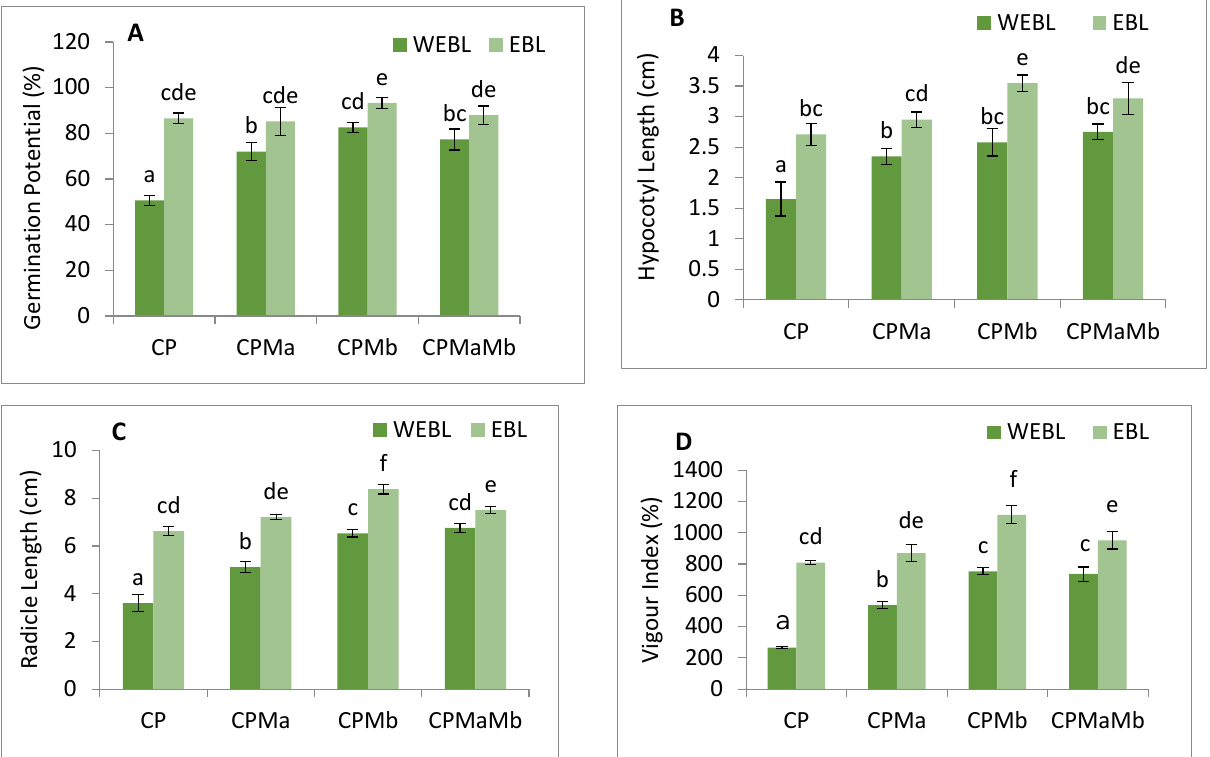
(Figure 1A), hypocotyl growth (Figure 1B) and radicle growth (Figure 1C). The vigour index was used to track the overall growth of the seedlings (Figure 1D). Decreased germination potential, seedling growth and vigour index were observed when CP-treated seedlings were compared in contrast to without CP. However, seed pre-soaking with EBL along with supplementation with Ma and Mb alone and in combinations, i.e., EBLMaMb significantly recovered the seedlings’ growth. Treatment of EBL (100 mM) enhanced the germination potential (41.57%), hypocotyl length and radicle length (39.1 and 45.6%) when compared with CP only. However, supplementation of Ma along with CP, Mb with CP and together in a combination of Ma and Mb along with CP also improved the growth profile of the seedlings when compared with CP only. The sharpest rise was seen in the germination potential by 45.7%, hypocotyl length by 53.5%, radicle by 57% and overall growth, i.e., vigour index by 76.1% when Mb was inoculated with EBL treatment and compared with CP-treated seedlings. The data was statistically analysed by using two-way ANOVA which showed a significant difference in the various growth attributes. The results show that CP stress considerably impeded seedling growth, which was positively influenced by supplementation with EBL and PGPRs, showing that EBL and PGPRs had an ameliorative impact.